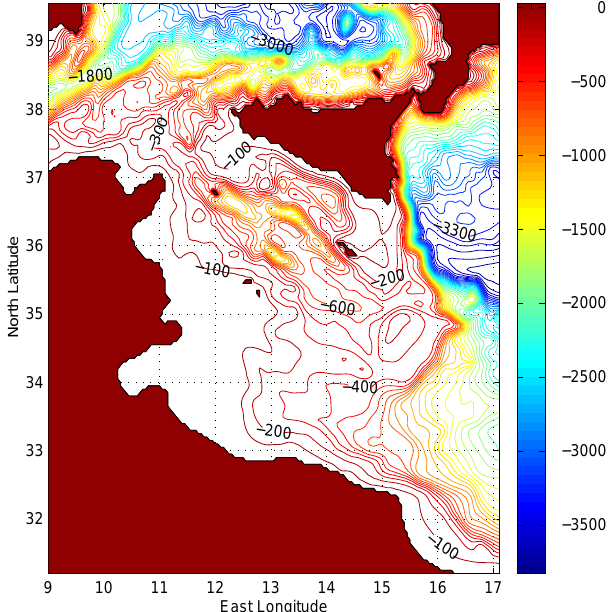
Fig. 2. The model bathymetry of the Central Mediterranean Sea based on the U.S. Navy bathymetric DBDB1 data set at a resolution of (1/60) ◦ . Depth is in meters and the contour interval is